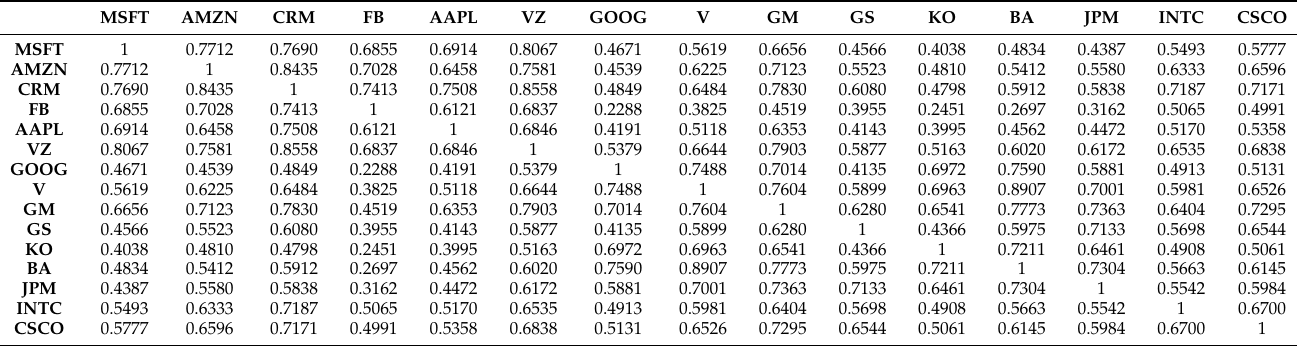
Table 6. The correlation matrix for N = 15 assets.